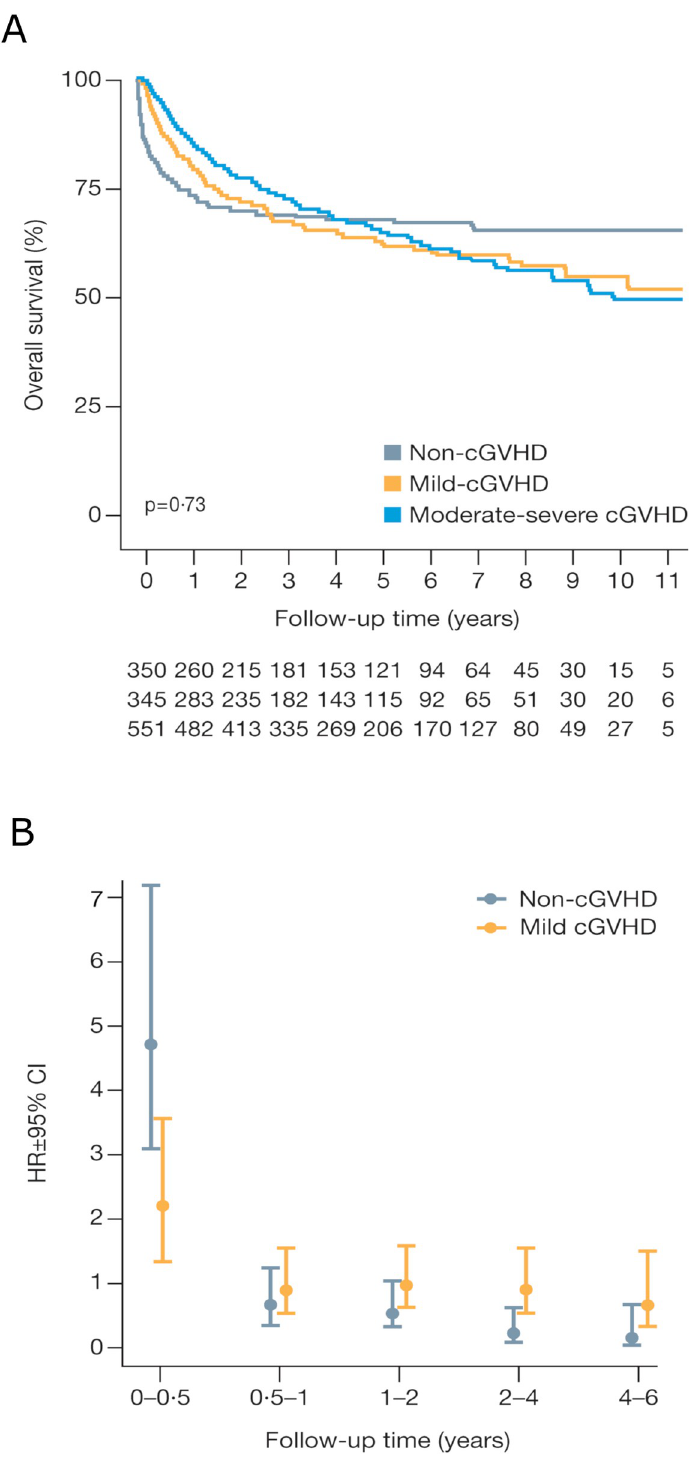
Fig 2. Overall survival rates and hazard ratios by cGVHD status among patients who survived � 6 months post- HSCT. (A) Overall survival per follow-up year. (B) HRs and 95% CIs from the comparison of death rates in non- cGVHD and mild cGVHD patients, in reference to moderate-severe cGVHD patients, adjusted for age, sex, calendar year of HSCT, donor and source.